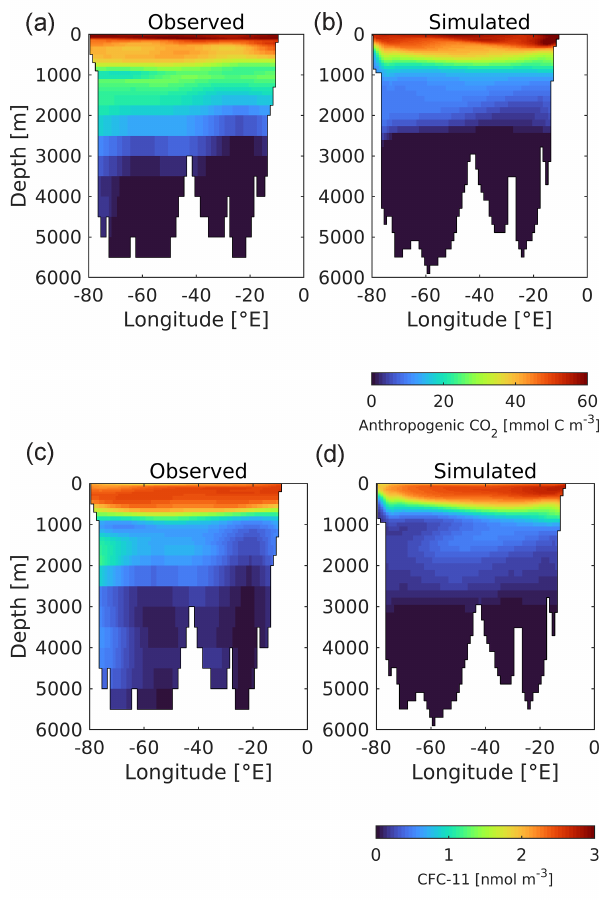
Figure 19. Observed ( a, c ; Key et al., 2004) and modelled (b, d) Atlantic sections (30 ◦ N) of anthropogenic CO 2 ( a, b ; mmolCm − 3 ) and CFC-11 ( c, d ; nmolm − 3 ) in the 1990s.